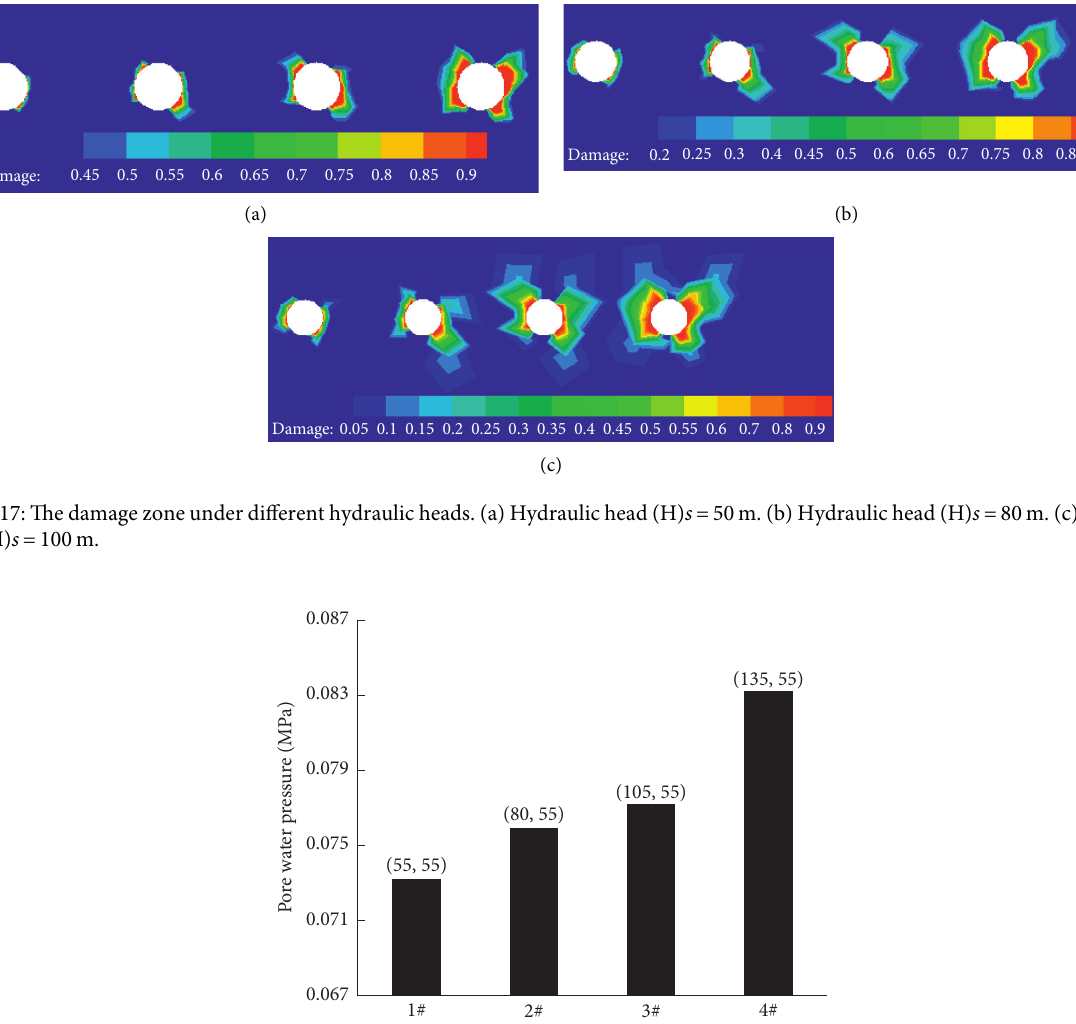
Figure 18: Different thickness of the overlying soil pore water pressure.